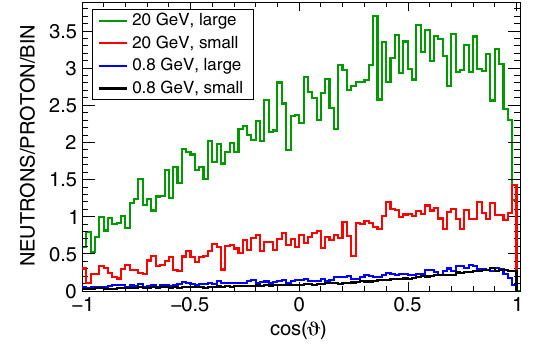
FIG. 12. Neutron emission angle from the spallation target with respect to the direction of the protons for all settings. The x-axis has 100 bins.